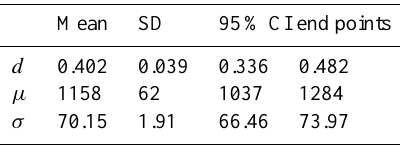
Table 5. Summary posterior statistics for Nile minima time series for the long-memory parameter d , mean µ , and noise variance σ .